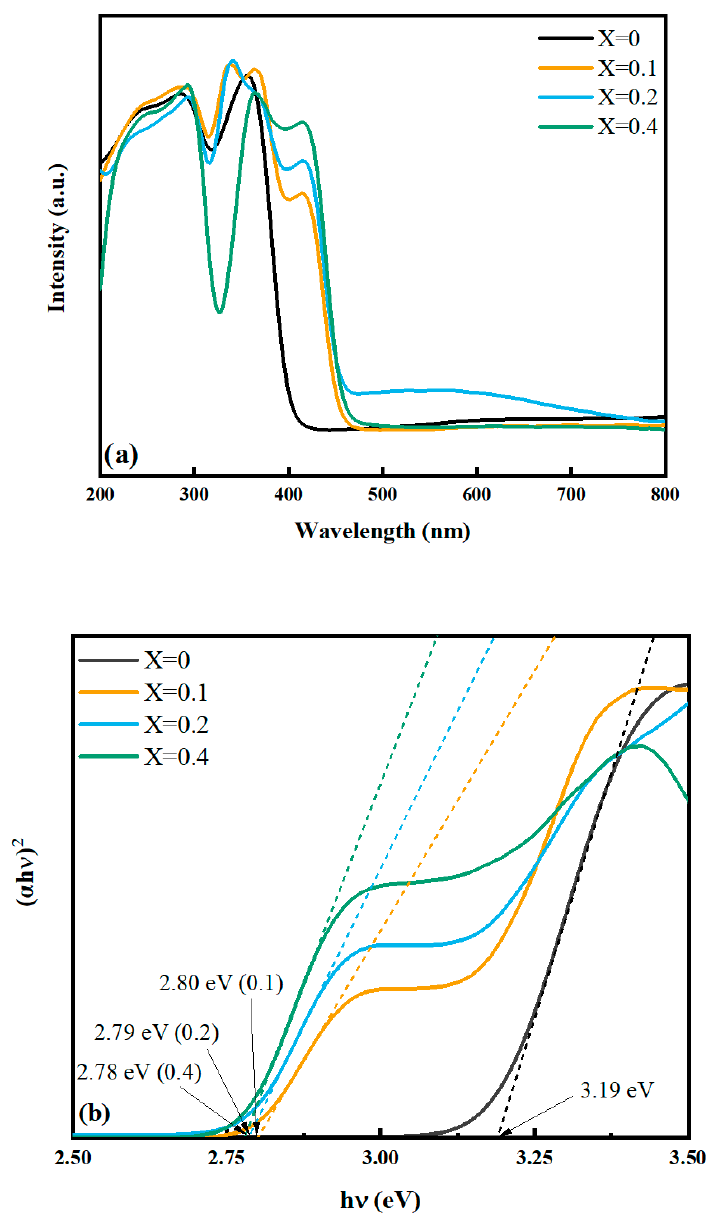
Figure 5. ( a ) UV-vis spectra and ( b ) plots of ( α h ν ) 2 versus energy (h ν ) of all prepared photocatalysts